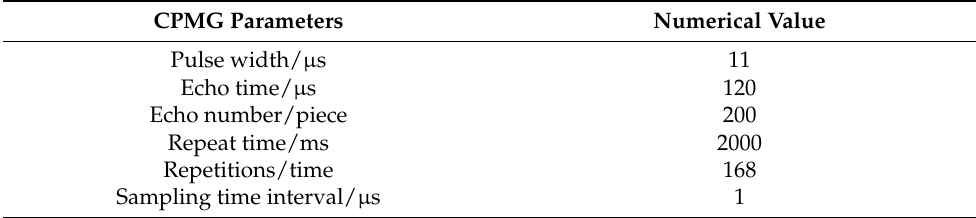
Table 1. CPMG pulse parameters.